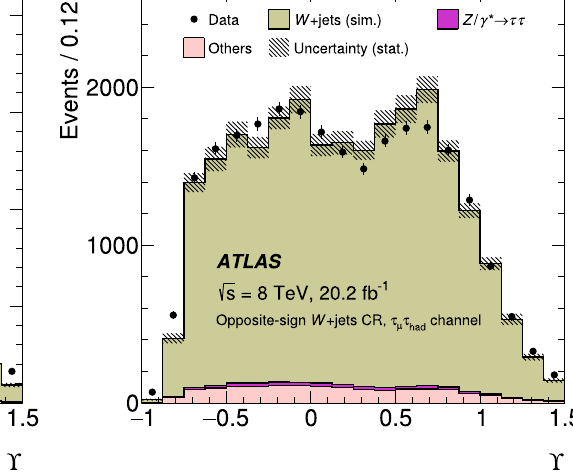
Fig. 2 The ϒ distribution in the opposite-sign W +jets control region in the τ e – τ had (left) and τ μ – τ had (right) channel. The contributions of Z /γ ∗ → ττ andof Z /γ ∗ → (cid:14)(cid:14) and t ¯ t (other)eventsareestimatedfrom the simulation. The τ polarisation in Z /γ ∗ → ττ events is obtained